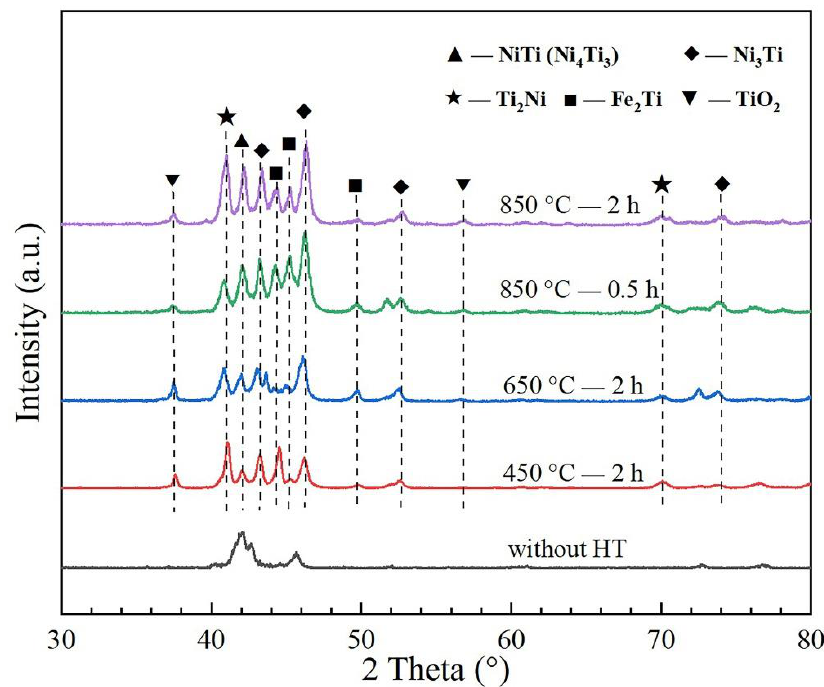
Figure 3. XRD patterns of the as-fabricated and heat-treated 55NiTi+5Ni coating samples at different annealing temperatures.